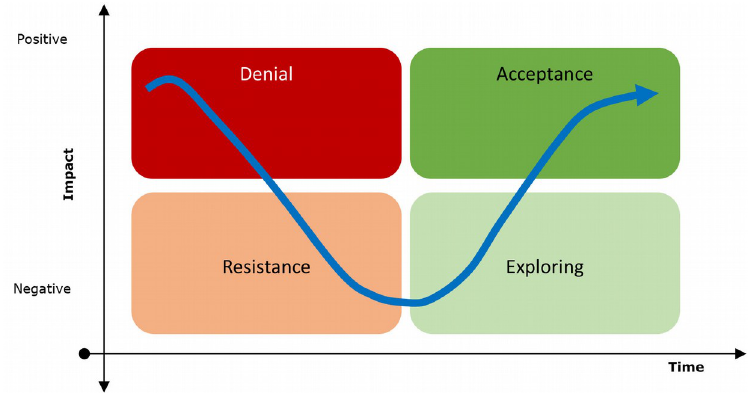
Figure 16. Change